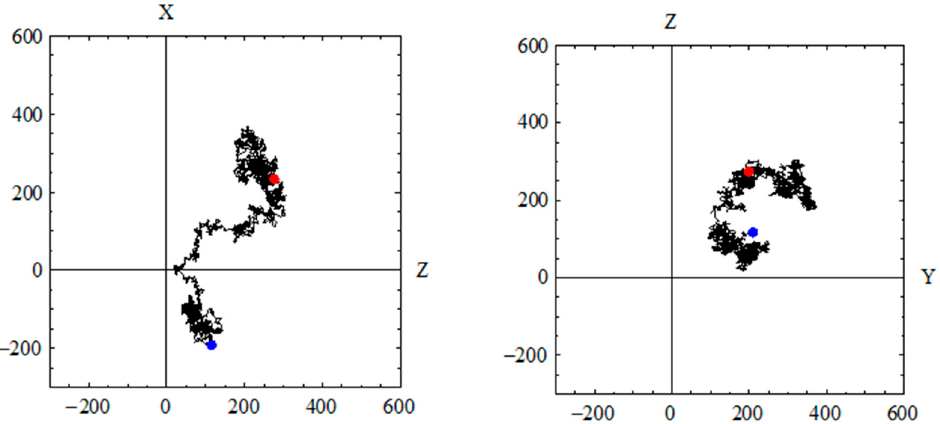
Fgiure 5. Cont . Fgiure 5. Cont . Figure 5. Cont